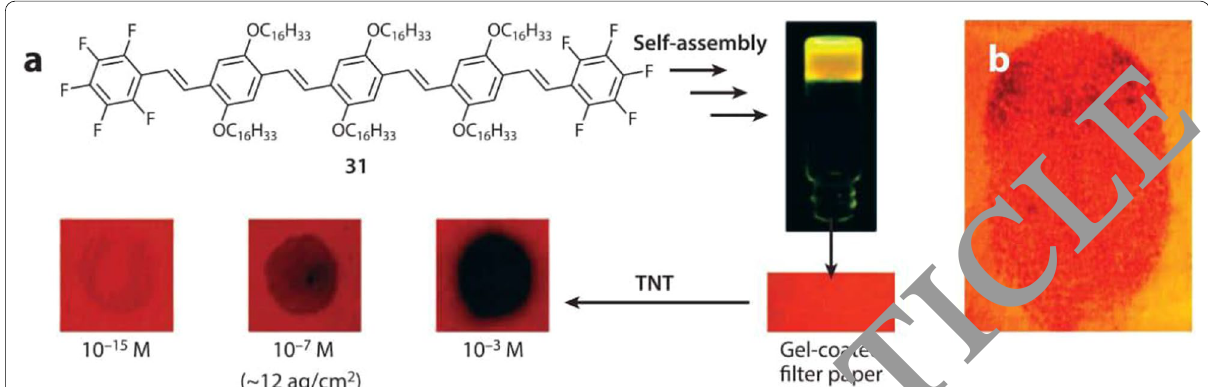
Fig. 7 a The chemical structure of conjugated Perfluoropyridine molecules with π bonds that, after molecular self-assembly, are turned into a gel and placed on a piece of paper; b fluorescent microscope image of paper impregnated with conductive gel A exposed to very small amounts of TNT explosives